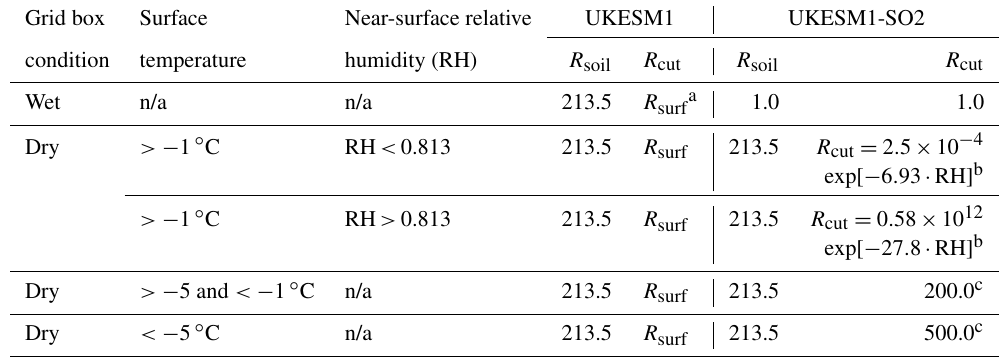
Table A1. Summary of the representation of R cut and R soil in UKESM1 and UKESM1-SO2. Units for resistance values are sm − 1 .